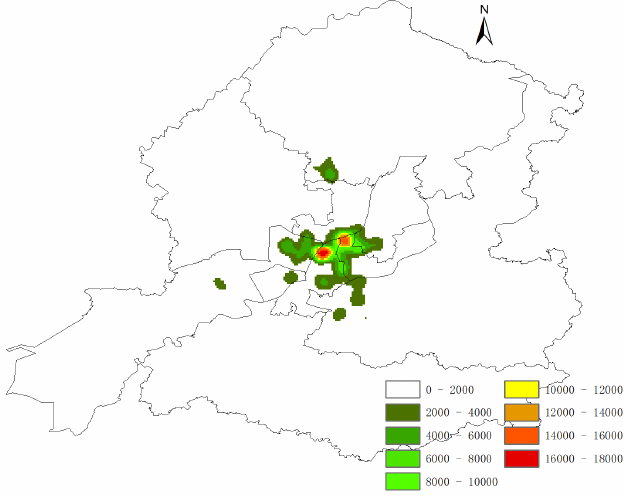
Figure 3. Results of kernel density analysis of Luckin coffee.